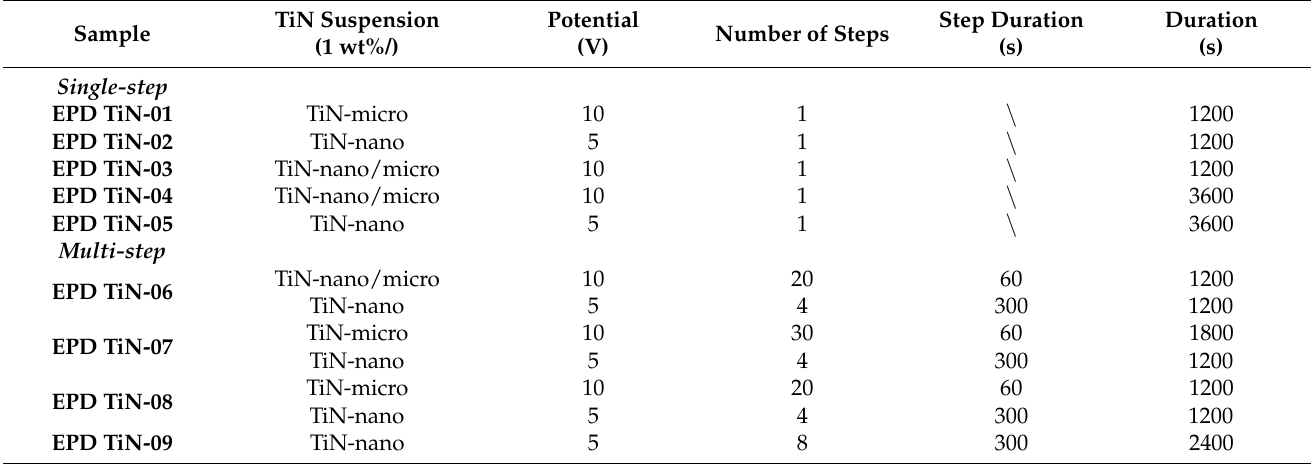
Table 1. Selection of EPD